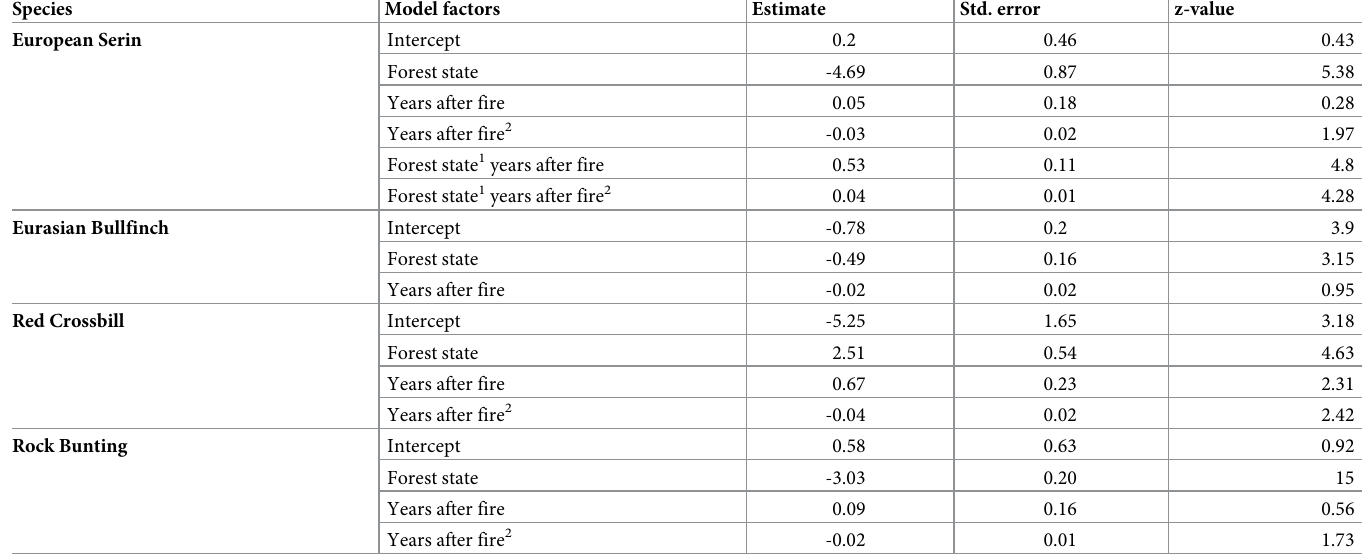
For the factor “forest state”, a negative coefficient indicates a higher abundance in burnt forests compared to control forests. 2 For the factor “years after fire”, a negative coefficient indicates a decrease in abundance with years after